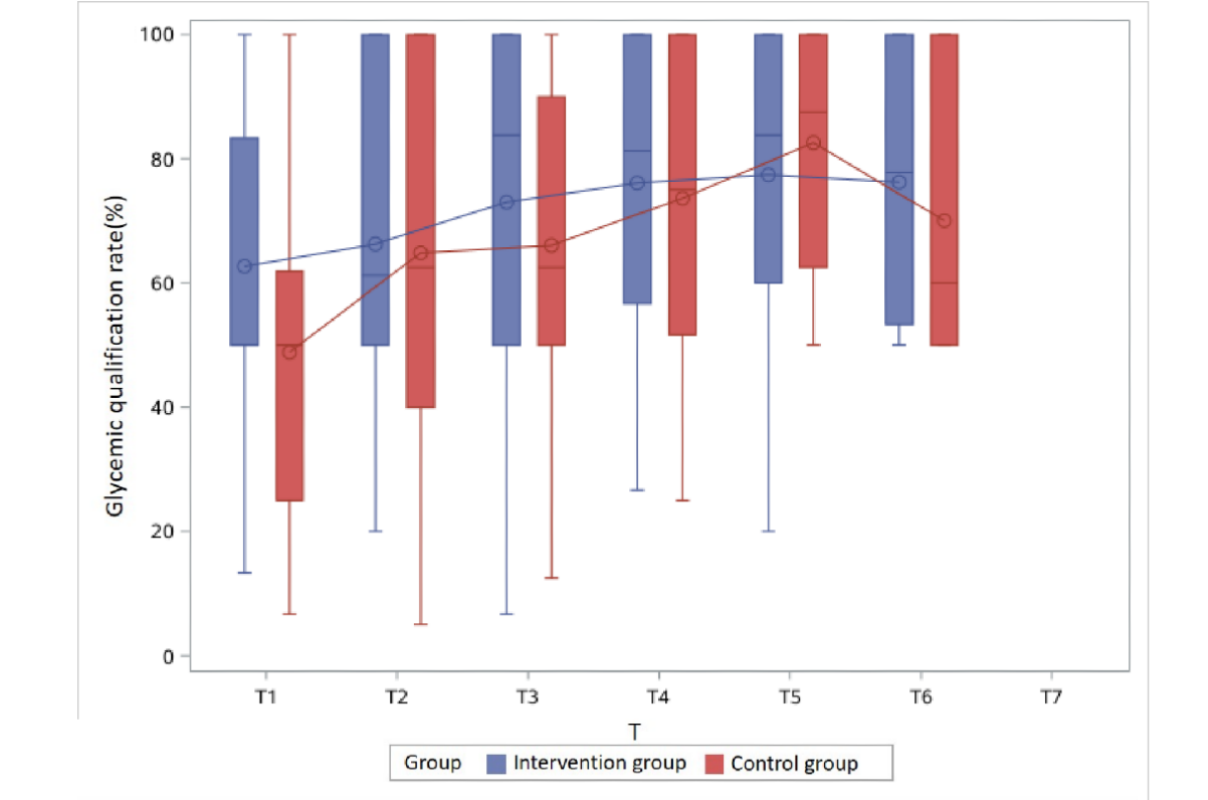
Figure 4. Glycemic qualification rate of the intervention and control groups in Group 3 (enrolled between 27 and 28 [+6] gestational weeks) at different time points. T: 2-week period.